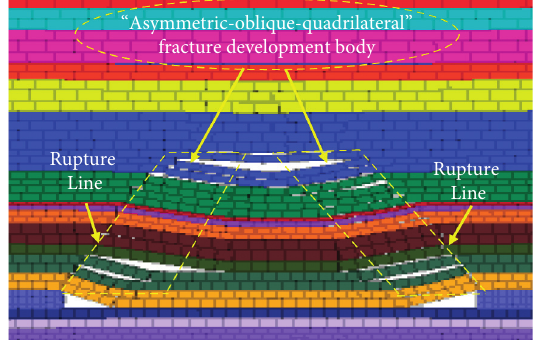
Figure 10: Mining to 70m.